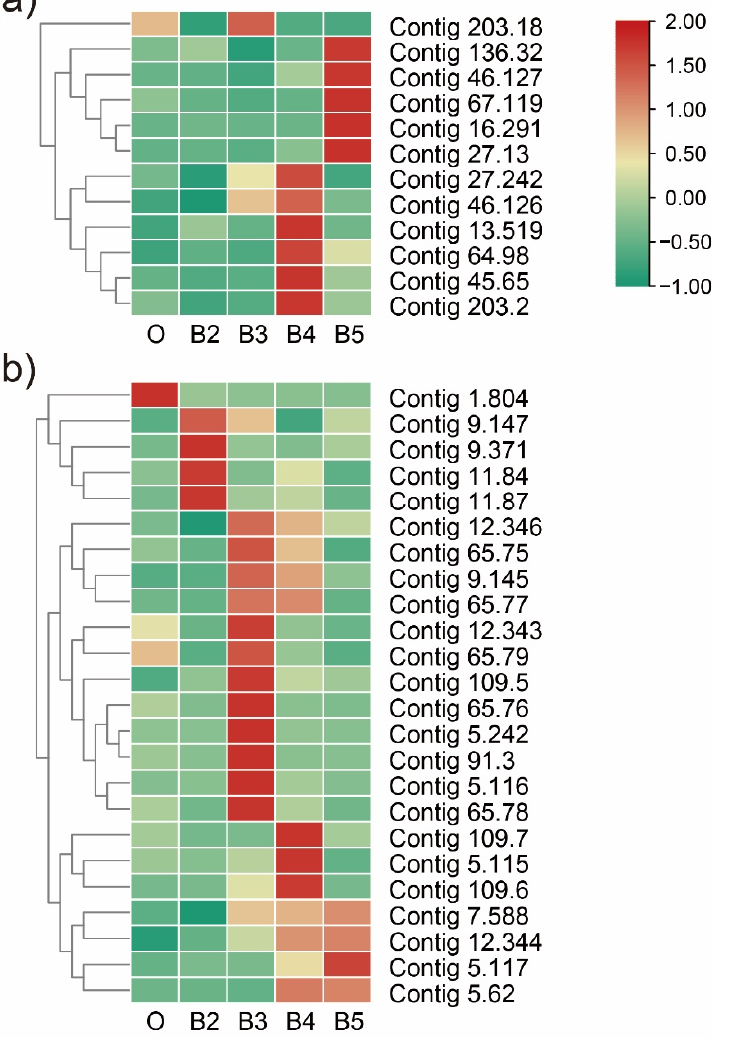
Figure 8. Gene expression profiles of the 20E and JH pathways. ( a ) Genes related to 20E synthesis. ( b ) Genes related to JH synthesis, degradation, and transport. The color scale on the right shows the FPKM values for each developmental stage from red (high) to green (low), standardized by min–max normalization.